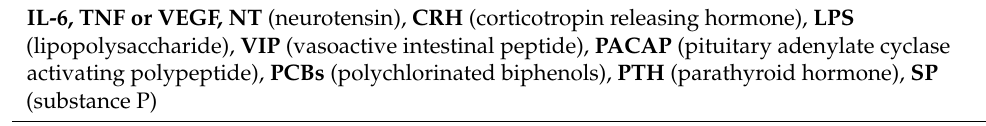
Table 2. Mast Cell Triggers without